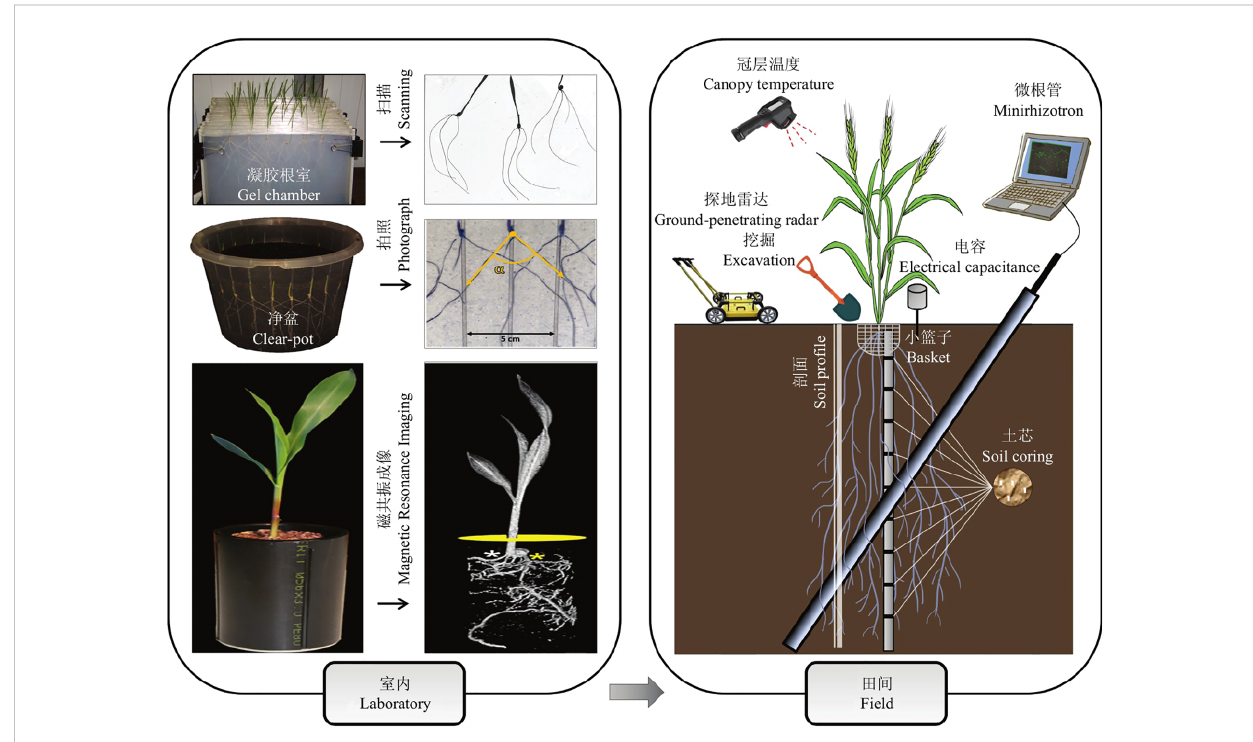
FIGURE 1 Main methods for studying root